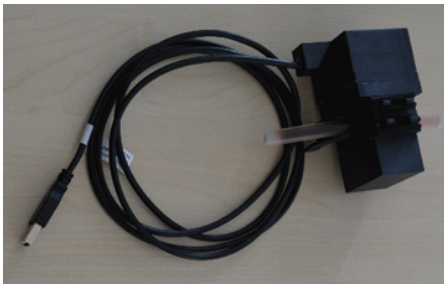
Figure 8. Image of the assembled sensor as used in the clinical validation study. Communication and power supply were realized using a USB 3 interface. A short tube segment was inserted to showcase sensor attachment to the CBI system.